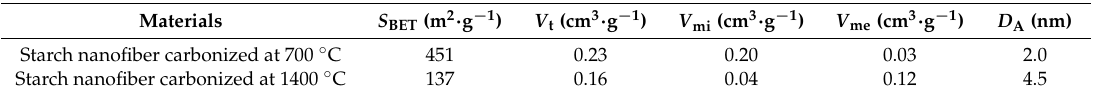
Table 1. Physical characteristics of the carbonized starch nanofibers. S BET : surface area; V t : total volume; V mi : micropore volume; V me : mesopore volume; D A : diameter.